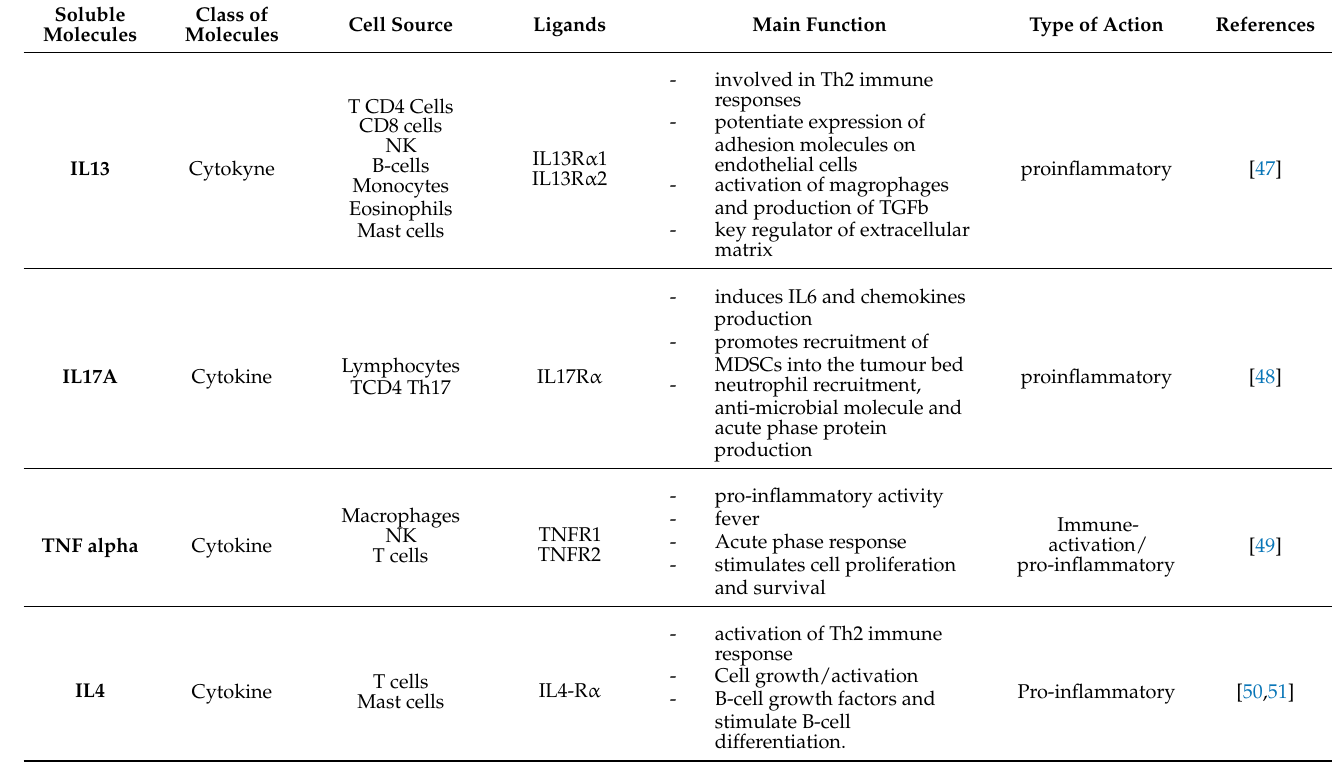
Table 4. Soluble immune molecules showing a statistically significant over-expression in responder patients: characteristics and